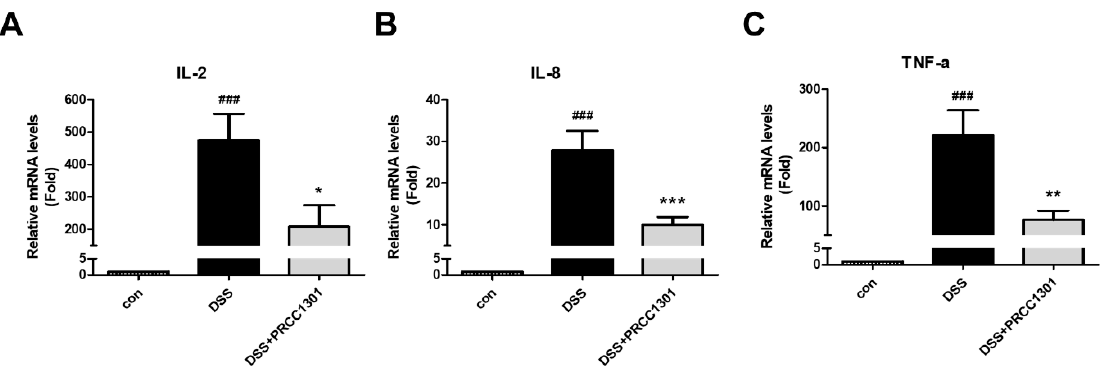
Figure 1. PRCC-1301 extracellular vesicles (EVs) inhibited pro-inflammatory cytokine gene expression in Caco-2 cells. ( A ) mRNA expression level of ( A ) IL-2, ( B ) IL-8, and ( C ) TNF- α in Caco-2 cells. The results are shown as mean ± SEM. ## p < 0.001 compared with control, * p < 0.05 and ** p < and *** p < 0.001 compared with DSS 0.01 and *** p < 0.001 compared with DSS group.